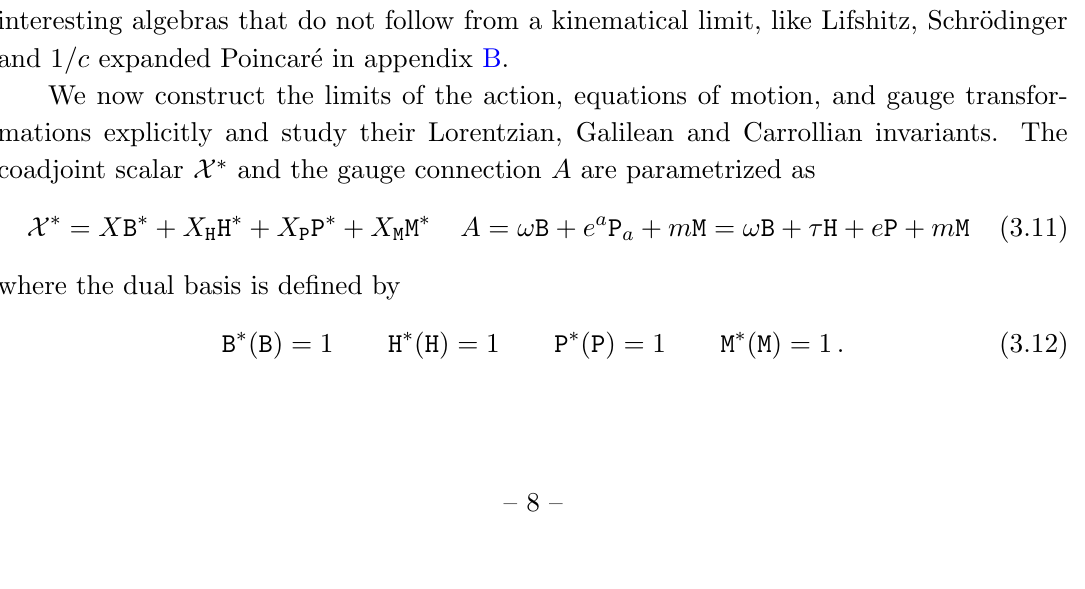
Figure 3 . Kinematical limits of (anti-)de Sitter: non-relativistic/Galilean (^ c = 1 ( ^ (cid:3) ! 0); ultra-relativistic/Carrollian ( ^ C ! 0). Arrows with two lines imply there are two di(cid:11)erent limits, depending on the sign of the cosmological